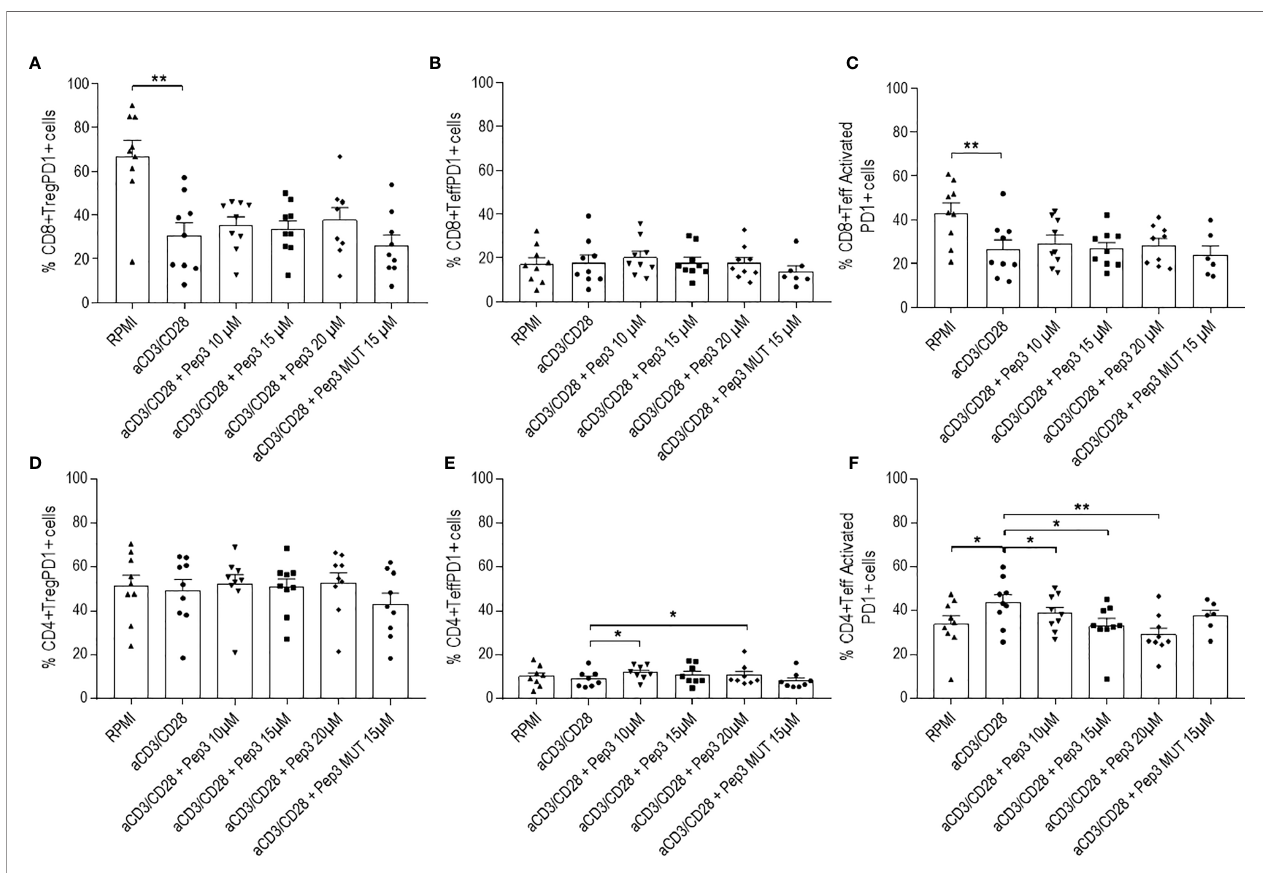
FIGURE 4 | Frequency of CD8+PD1+ and CD4+PD1+ cell populations relative to thyroid cancer patients PBMC upon treatment with peptide 3 and subsequent stimulation with anti-CD3/CD28 beads for 6 days. Upper graphs show the percentages of CD8+ Treg PD1+ cells (A) , CD8+ Teff PD1+ cells (B) , CD8+ Teff activated PD1+ cells (C) . Lower graphs show the percentages of CD4+ Treg PD1+ cells (D) , CD4+ Teff PD1+ cells (E) , CD4+ Teff activated PD1+ cells (F) . Percentage of PD1+ cells was evaluated in comparison to the corresponding parental subset under evaluation. Statistical signi fi cance was evaluated using Wilcoxon matched-pairs signed rank test. Data are expressed as mean ± SEM, and each dot corresponds to an individual TC patient (n = 9). *p < 0.05 **p <